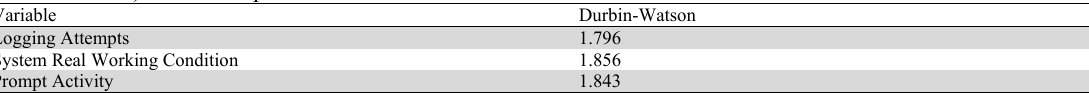
(Durbin-Watson) test of Independent Variables